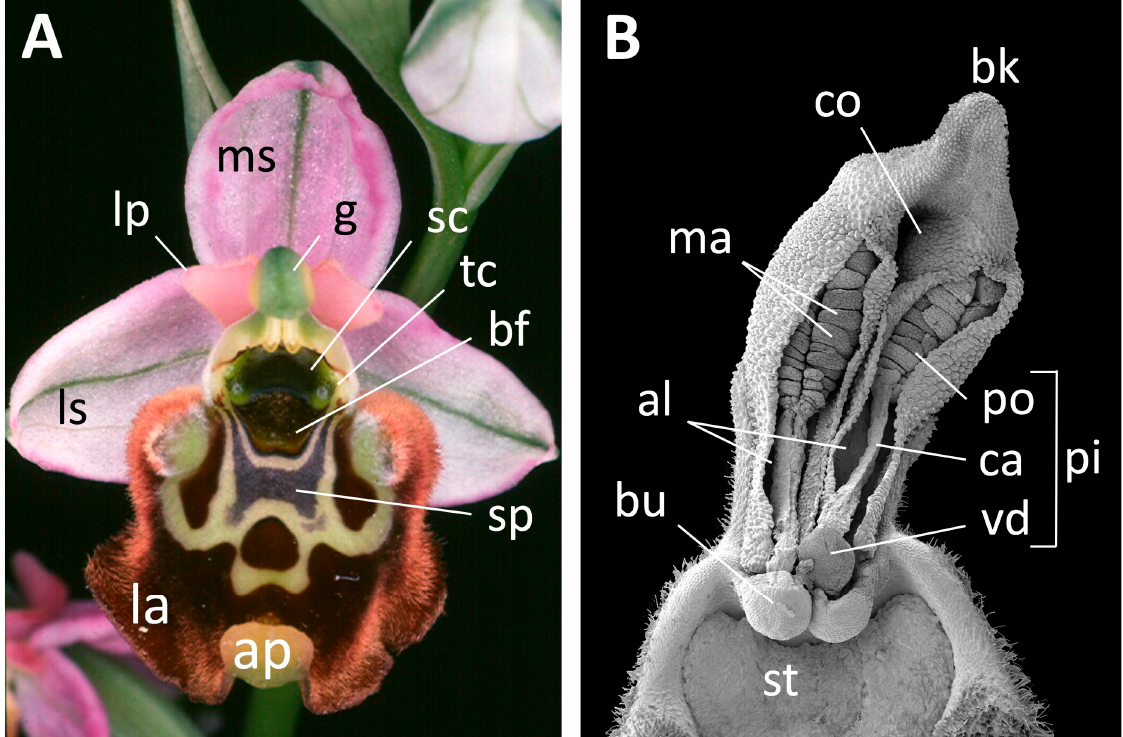
Figure 2. Terminology of a bee orchid flower. ( A ) Floral features, exemplified by microspecies O. episcopalis (mesospecies Fuciflora , macrospecies Fuciflora). ( B ) Gynostemium features, exemplified by O. cretensis (mesospecies Mammosa , macrospecies Sphegodes). Labels on ( A ): la, labellum (lip); lp, lateral petal; ms, median sepal; ls, lateral sepal; g, gynostemium (column); sc, stigmatic cavity; tc, temporal callosity (“pseudoeye”); bf, basal field; sp, speculum; ap, appendix. Labels on ( B ): al, anther locules; bu, bursicle (enclosing viscidial disc); bk, beak; co, connective; st, stigmatic surface; po, pollinium; ma, massulae; ca, caudicle; v, viscidial disc (these features are collectively termed the pollinarium–pi). Images: A = Richard Bateman, B = Paula Rudall.